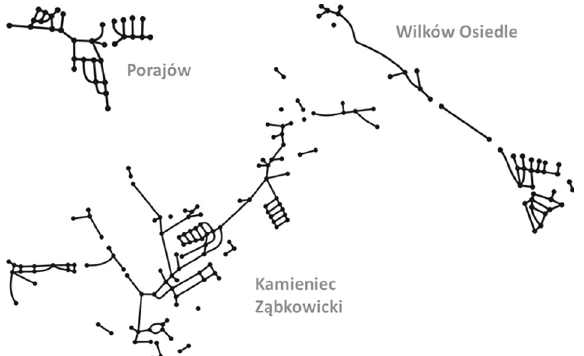
Fig. 9. Graphs depicting the morphology of former urban settlements (US). Source: own work.